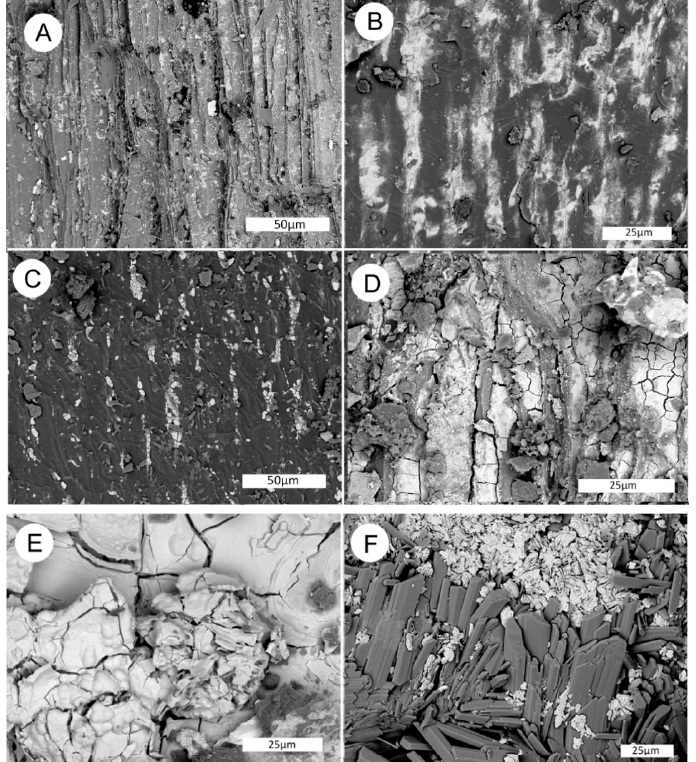
Figure 26. SEM images of carbonized wood layer, Moab, Utah specimen. ( A ) Secondary electron image showing relict cell structure. ( B , C ) Backscattered electron images, longitudinal view of tracheid cells showing cabonized tissue (dark), and the uranium mineral coffinite (light). Coffinite primarily occurs within cell lumina. ( D ) BSE image shows carbonized cell walls, with luminafileld with zippeite, probably formed as an alteration product of coffinite. ( E ) Surface crust containing nearly pure zippeite. ( F )Surface curst containing tabular gypsum crystals (dark) and microcrystalline Na-zippeite (light).